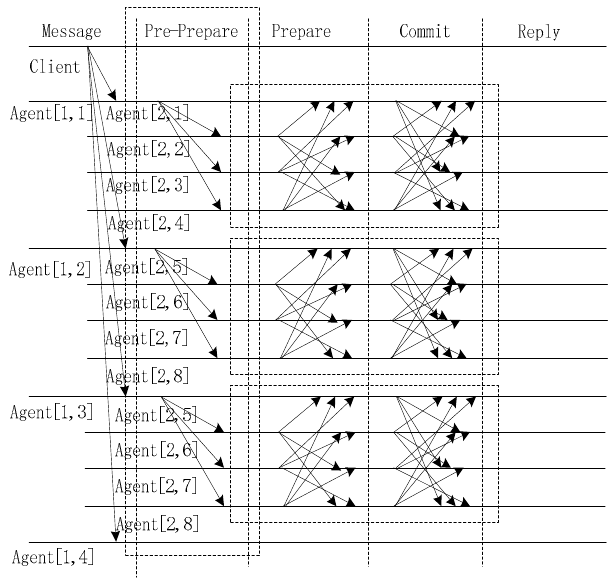
Figure 3. Pre-preparation process of the scalable dynamic multi-agent hierarchical PBFT algorithm. Algorithm 1. Agent-based layer for SDMA-PBFT.